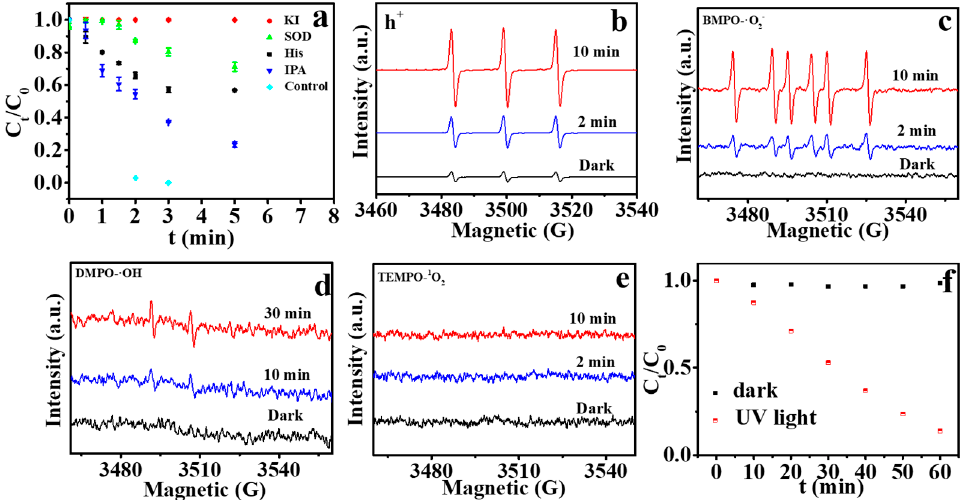
Figure 7. ( a ) Removal efficiency of MC-LR in the presence of different scavengers by L-MIL- 101(Fe)/TiO 2 ; ( b – e ) ESR spectrum of the reaction system obtained by various probes (CPH, BMPO, DMPO and TEMPO for h + , • O 2 − , • OH, and 1 O 2 respectively) under UV irradiation; ( f ) FFA decay with irradiation time over MIL-101(Fe)/TiO 2